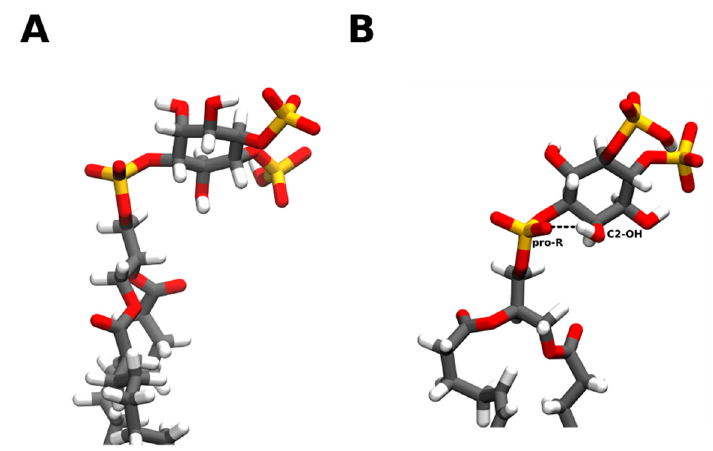
Figure 3. Examples of PI(4,5)P 2 headgroup tilt when inserted into a phospholipid membrane. PI(4,5)P 2 presents a significant headgroup tilt, when inserted into a bilayer, ranging from almost parallel to the membrane plane ( A ) to a more conservative ~40° tilt ( B ). Whilst the more dramatic headgroup tilt appears to be favored from interactions between its negatively charged phosphate groups and the positively charged membrane surface, the more moderate tilt surges from the establishment of intramolecular hydrogen bonds between the C2 hydroxyl and the pro-R-oxygen of the phosphodiester phosphate. Carbon atoms are colored in grey, hydrogen in white, oxygen in red, and phosphorus in orange. Snapshots obtained from a simulation of a bilayer consisting of 95:5 mol ratio POPC: PI(4,5)P 2 , using the CHARMM36m forcefield run in GROMACS2019. Images were modeled using VMD.